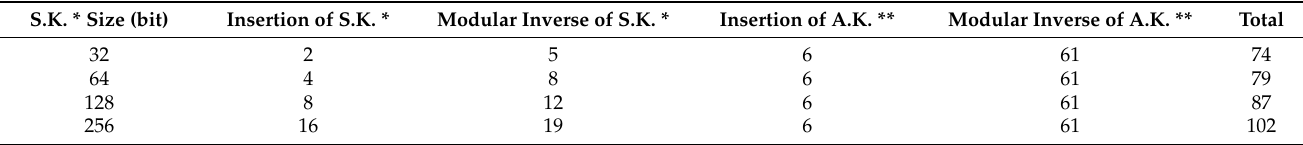
Table 2. Clock cycles for the generation of